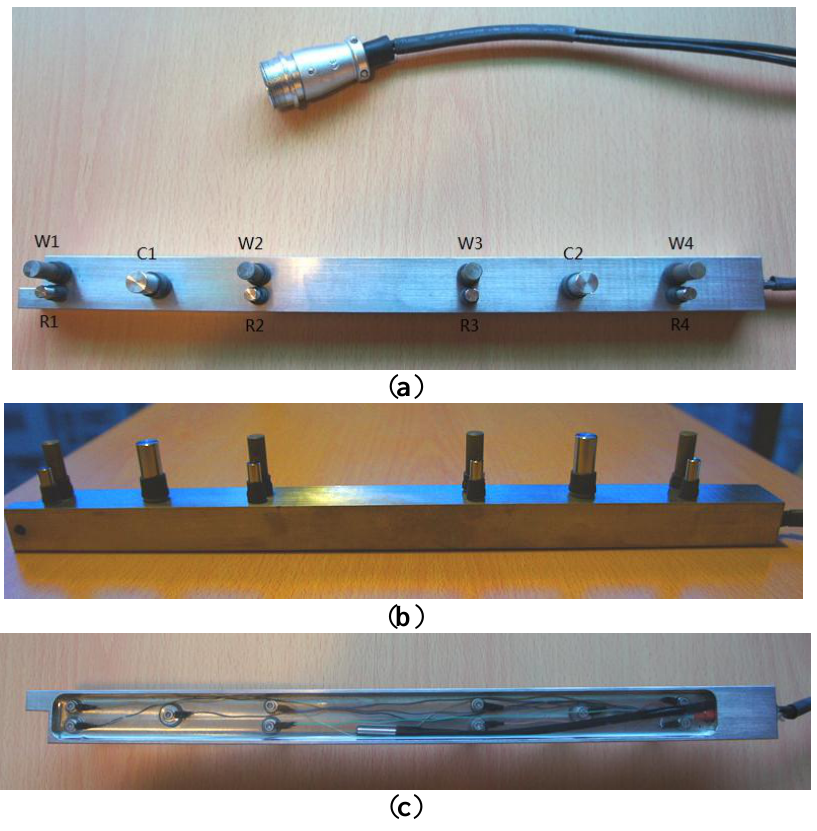
Figure 5. The geometrical sizes of the sensor.